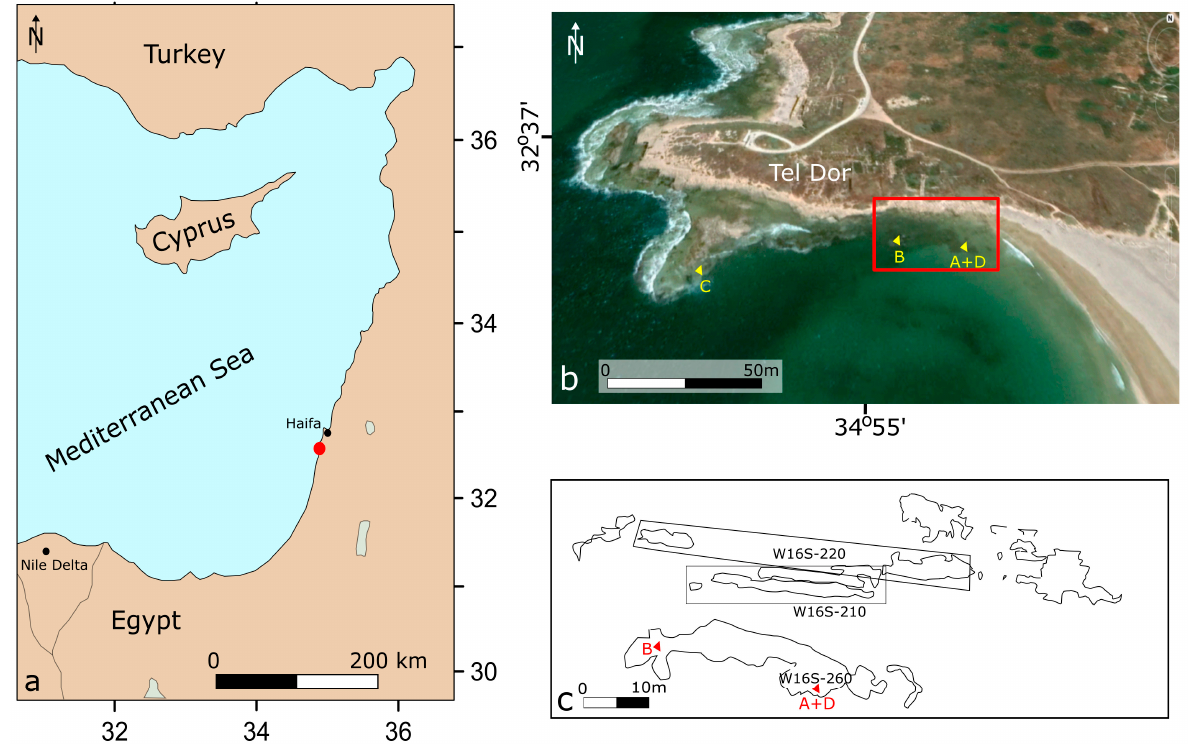
Figure 1. The archaeological site of Tel Dor, central Israel. ( a ) General location map. Red dot marks the location of Tel Dor. ( b ) An oblique view of the south slope of Tel Dor. The location of the cores mentioned in the text (marked A, B, C, and D) are denoted by yellow triangles. Image—Google Earth. ( c ) Sketch of the archaeological features discussed in the text (after [28]).